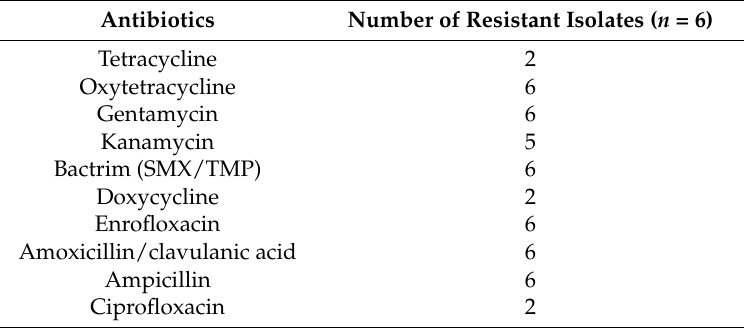
Table 1. Antibiogram profile of the Aeromonas hydrophila strains